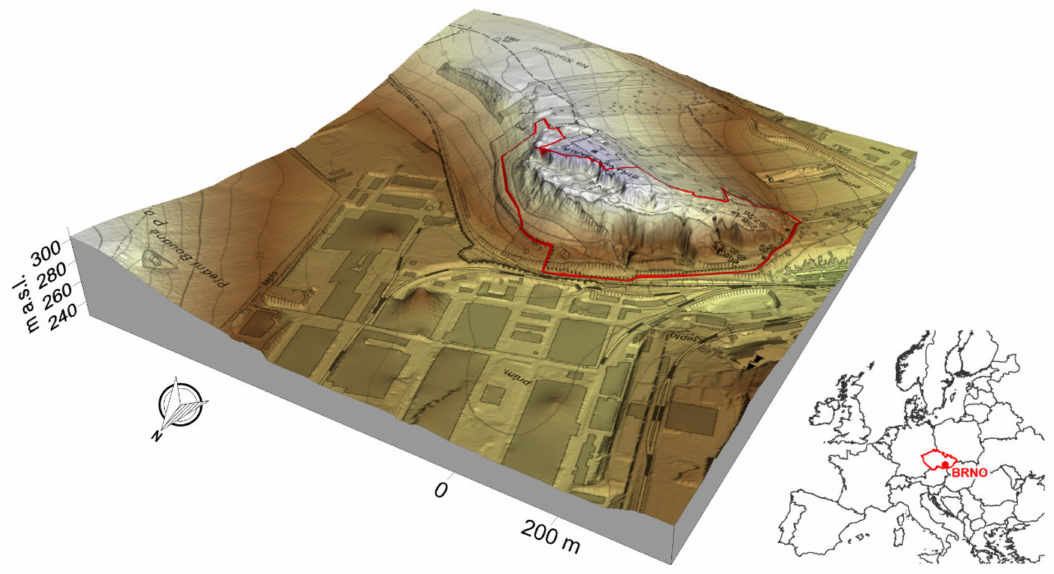
Figure 1. Str á nsk á sk á la in Brno, Czech Republic: Location of the study